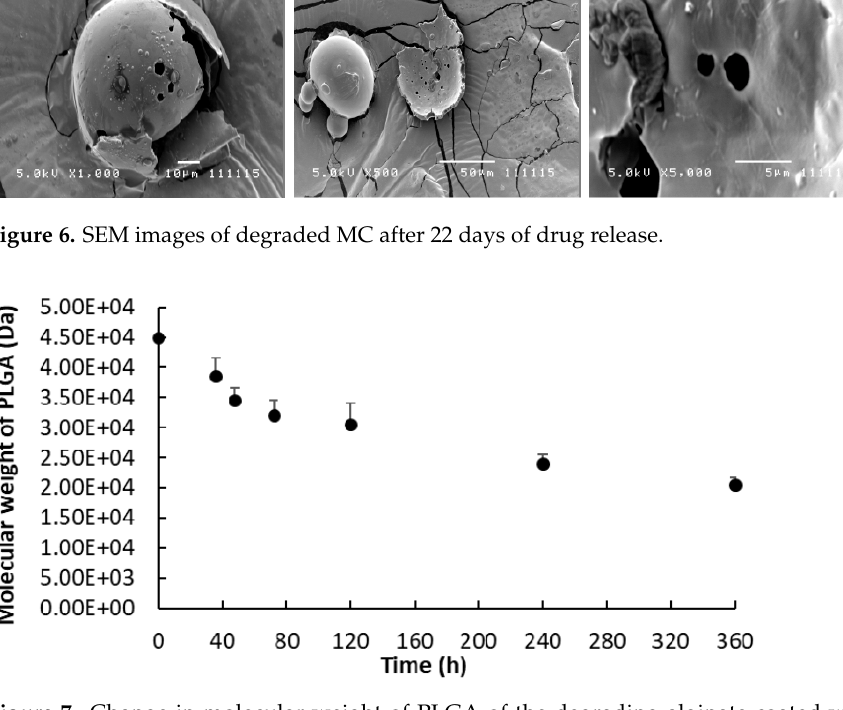
Figure 7. Change in molecular weight of PLGA of the degrading alginate-coated with chitosan nanoparticles loaded microcapsules as a function of incubation time ( n = 3).